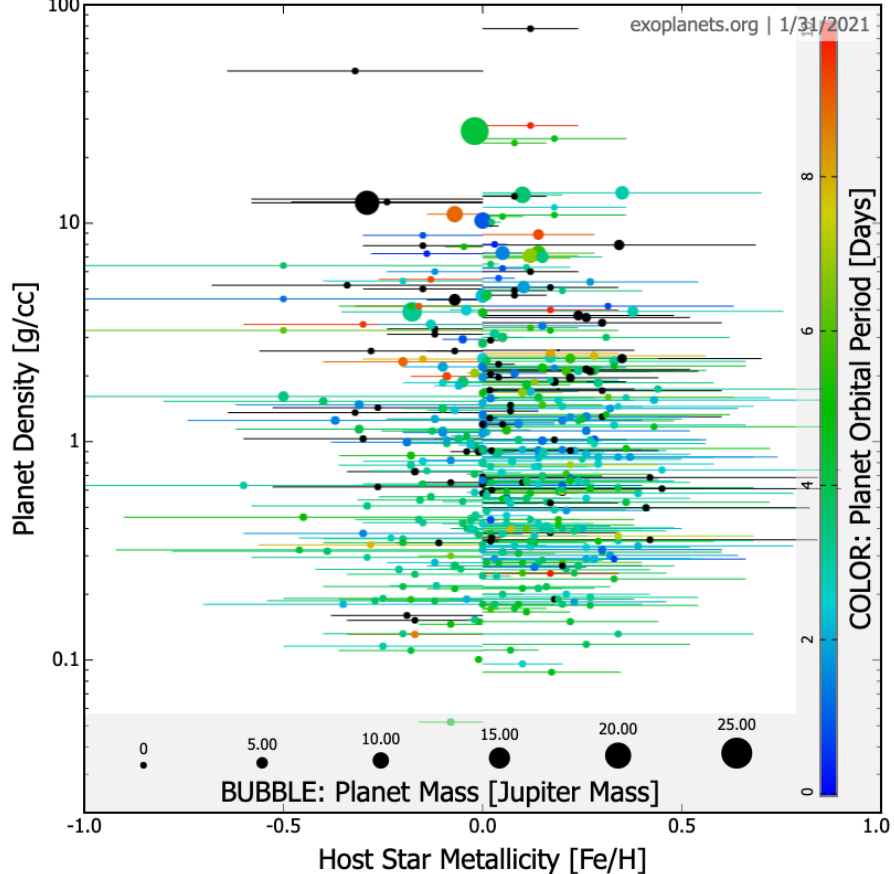
Figure 5. Exoplanet densities ( y -axis), masses (bubble-sizes), orbital periods (color), and their host– star metallicities ( x -axis). Star metallicity error-bars are depicted, but planet density error-bars are omitted for visual clarity. Black colors represent planets with orbital periods greater than 10 days. Color scale is chosen to maximize visual clarity. Data from the Exoplanet Orbit Database